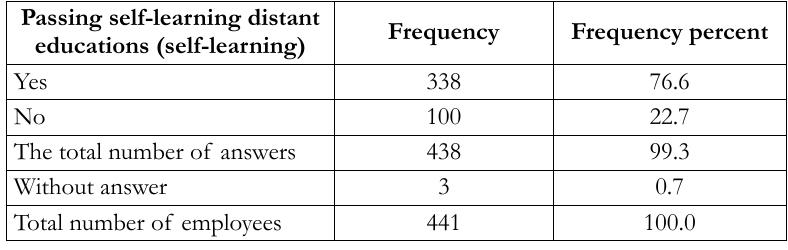
Table 5. The frequency distribution of employees